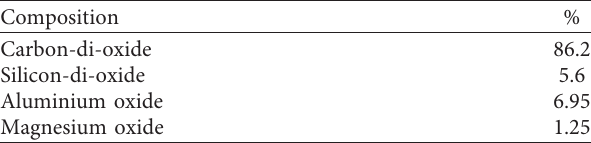
Table 3: Chemical properties of waste paper mass (XRF analysis).